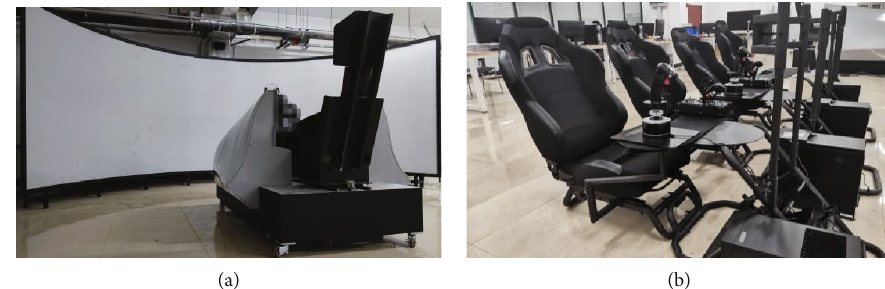
Figure 8: Some of the experimental devices used in this paper. (a) Full-size fi ghter cockpit and three-channel simulation test platform for sample library generation. (b) UAV control and command